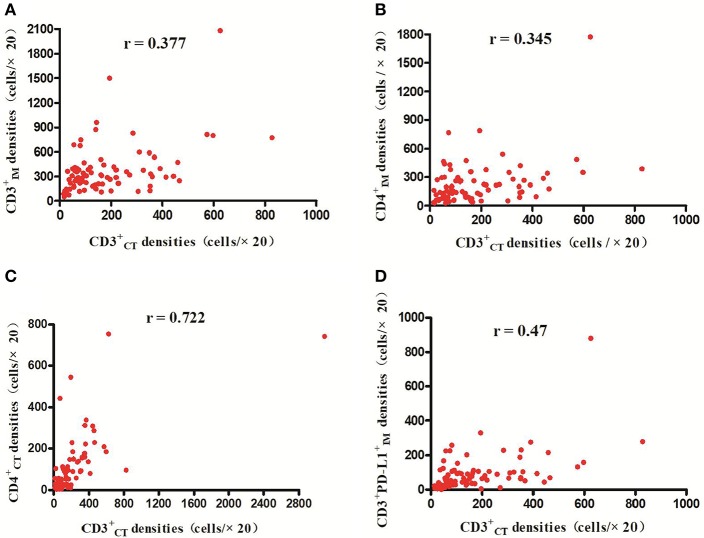
Positive correlations between CD3CT+ and CD3IM,+ CD4IM,+ CD4CT,+ and CD3+PD-L1IM+ cell densities, respectively (p < 0.01) (A–D).